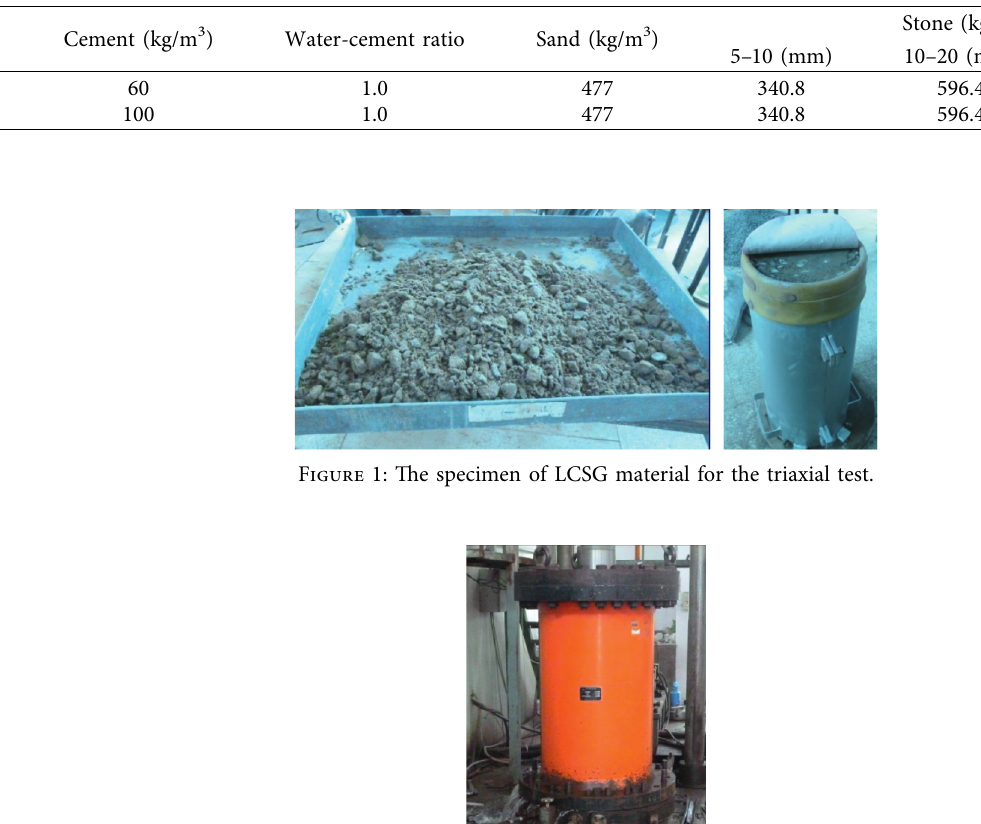
Table 1: Details of the test specimens.